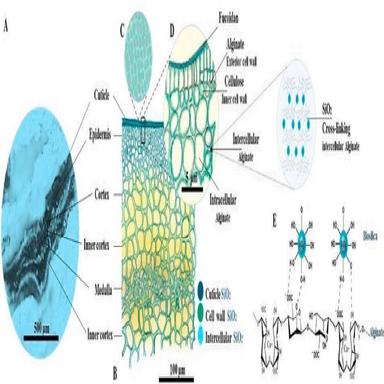
Schematic illustrations of the transversal cross-section of brown macroalga lamina indicating the typical anisotropic properties of the anatomical structure, specifically relevant to NanoBio-SiO2 distribution and deposition regions (. A) Confocal microscopic cross-section image of Ecklonia radiata micronized particle. B) Biosilica domains are highlighted through the intercellular structure and the cell walls. C) Surface view of the cuticle region showing biosilica distribution in the interstitia